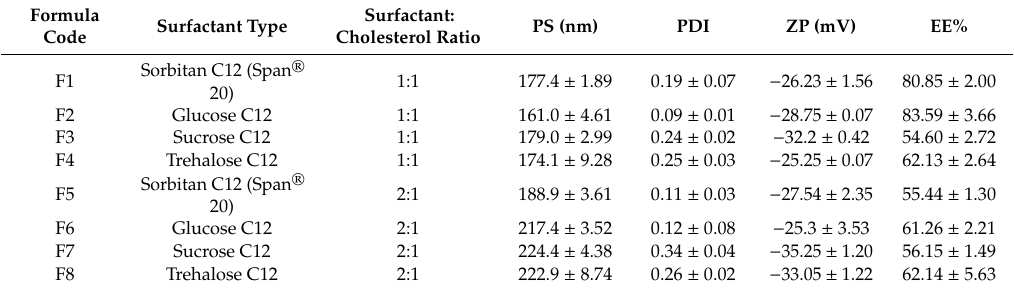
Table 2. Composition and characteristics of prepared niosomal